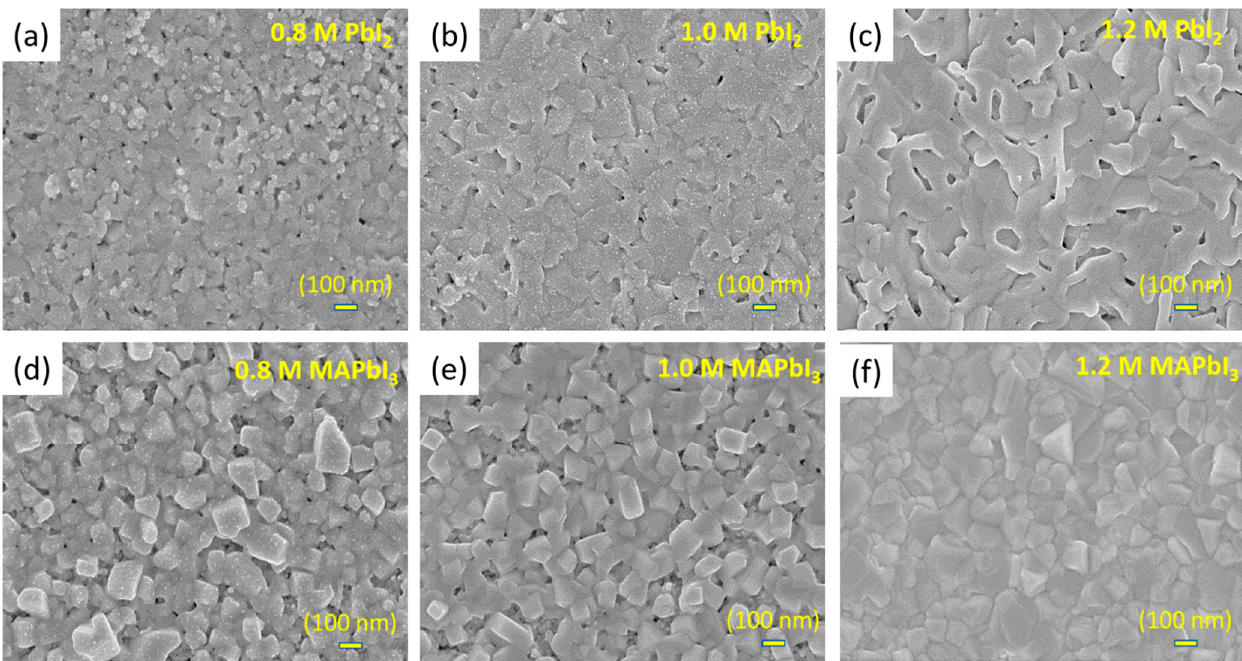
Figure 4. ( a – c ). SEM images of PbI 2 capping layers on top of mp-TiO 2 using different PbI 2 solution concentration; ( d – f ) SEM images of corresponding perovskite capping layers after conversion.